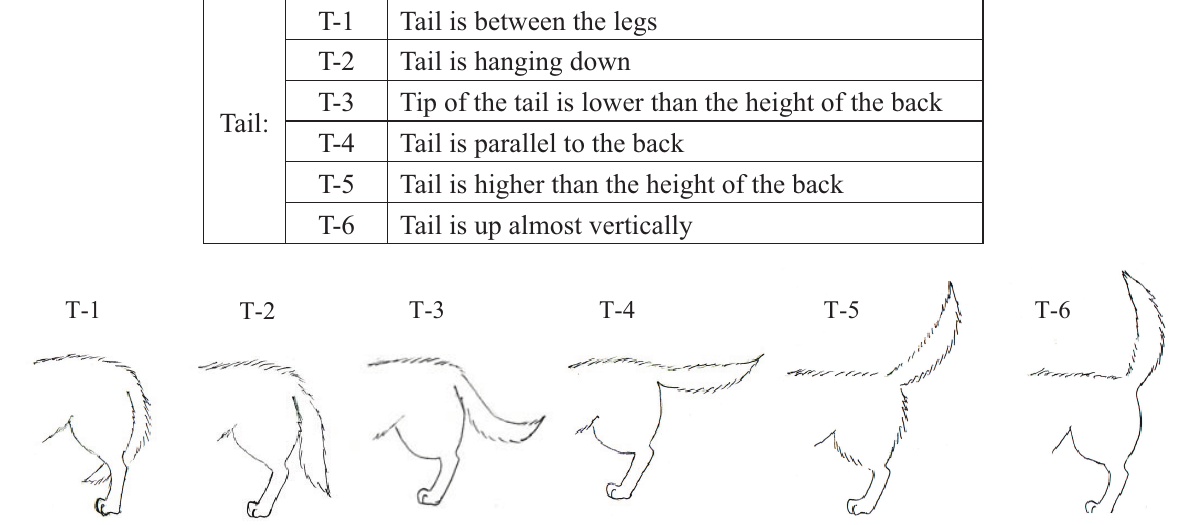
Table 3. Categories of dog tail-wagging (TW) during operant conditioning training.